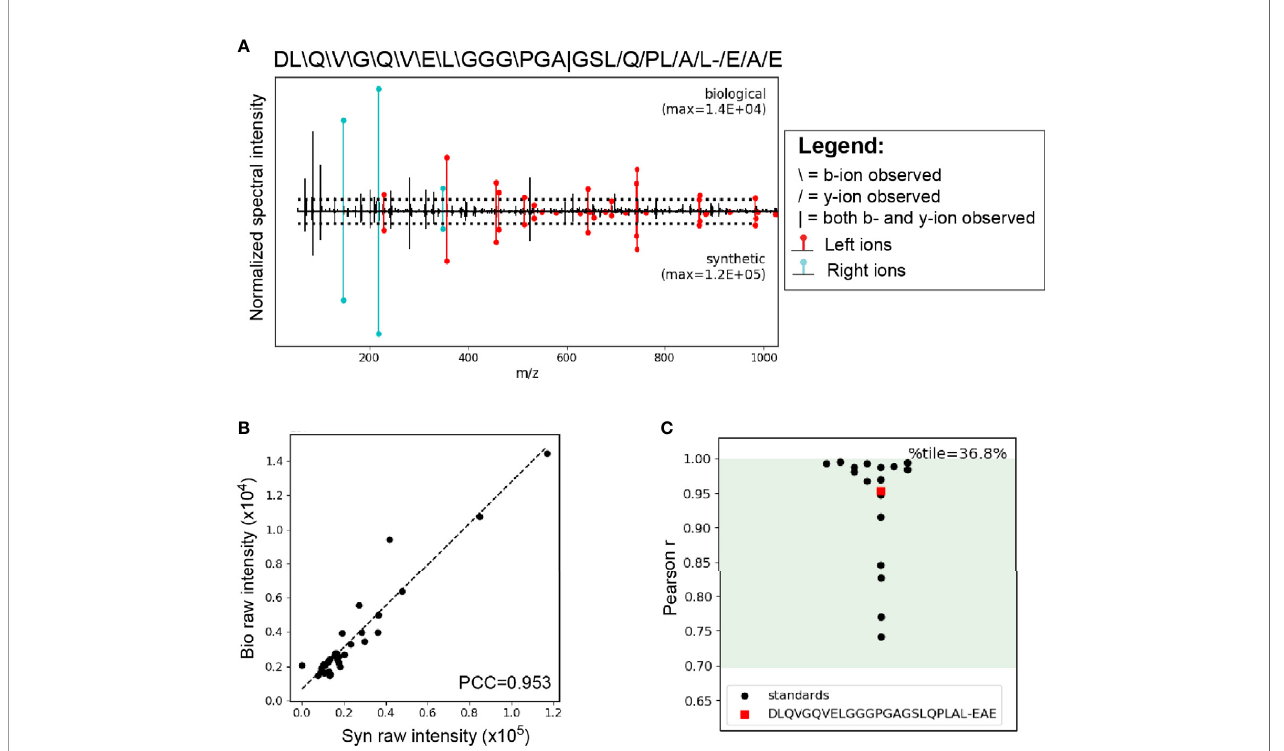
FIGURE 6 | LC-MS/MS analysis using the P-VIS approach con fi rms that HIP11 is present in human islets. Proteins were extracted from human islets, fractionated by size exclusion chromatography (SEC), and digested with the protease AspN, which cleaves at the N-terminus of aspartic acid (D) residues. Samples were analyzed by LC-MS/MS and data were searched using Agilent Spectrum Mill software. The predicted HIP11 AspN cleavage product DLQVGQVELGGGPGAGSLQPLAL-EAE was identi fi ed with high con fi dence and validated using the P-VIS approach. (A) Mirror plot generated by PSM_validator displaying the spectrum from the biological sample (positive y-axis) and the spectrum from the validation sample (negative y-axis). Peak intensities are normalized to the most intense peak in each spectrum. The intensity of the tallest peak in each spectrum is indicated. In the sequence map, “” , “ / ” , and “ | ” indicate that the spectrum from the biological sample contained a b-ion, y-ion, or both, respectively, corresponding to fragmentation at a given bond. Horizontal dotted lines indicate the user-de fi ned threshold for consideration of peaks in the Pearson correlation coef fi cient (PCC) calculation. Ions corresponding to fragmentation of a bond to the left (L ions) or right (R ions) of the hybrid junction are labeled in red and cyan, respectively. (B) Peaks that were present above the intensity threshold in at least one of the spectra were used to calculate the Pearson correlation coef fi cient (PCC) between the two spectra. For each peak, the intensity in the biological peptide spectrum (bio raw intensity) and the intensity in the spectrum for the synthetic peptide (syn raw intensity) were paired, and the pairs for all peaks were plotted. Calculation of the PCC for these values indicated that the spectra were highly correlated (PCC = 0.953). (C) Comparison of the PCC for the HIP11 match to the distribution of PCCs for internal standard peptides (ISPs). Data for the ISPs passed the D ’ Agostino-Pearson omnibus normality test (p = 0.229; p > 0.05 indicates that the null hypothesis cannot be rejected and the data can be treated as normal). Green shading indicates the 95% prediction interval based on one-tailed analysis of Fisher ’ s z-transformed PCC values. The PCC comparing the biological spectrum and the validation spectrum is shown (red square), and the percentile (%tile) is